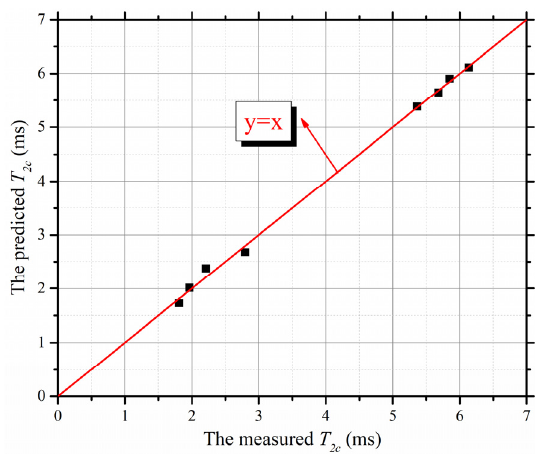
Figure 15. The predicted T 2 c versus the measured T 2 c . Red solid line indicates a slope of 1:1. The closer the black point is to the line, the smaller the difference between the predicted and measured T 2 c is.